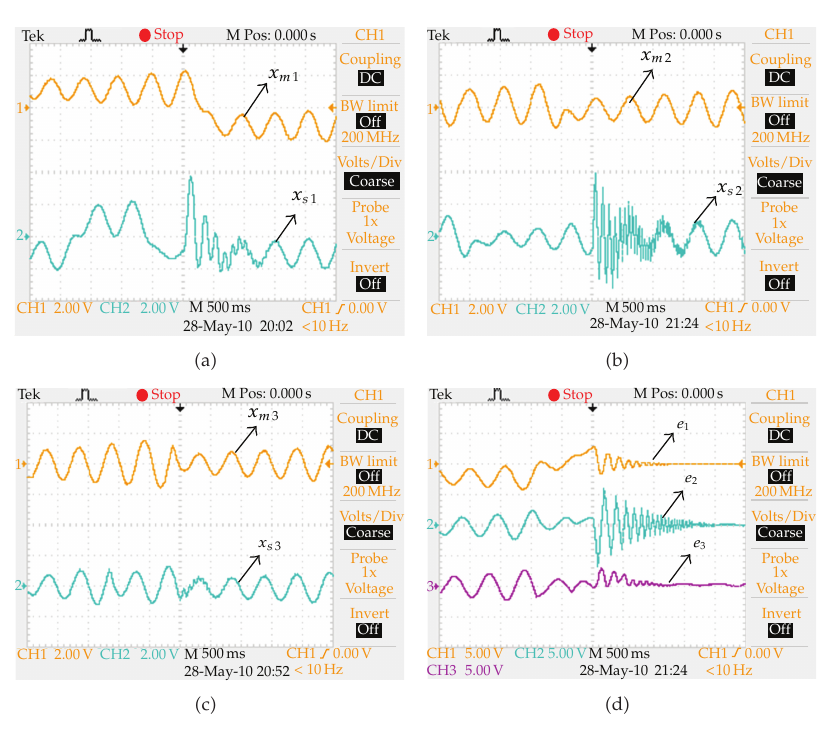
Figure 7: Experimental results of synchronization. (cid:2) a (cid:3) x m 1 versus x s 1 . (cid:2) b (cid:3) x m 2 versus x s 2 . (cid:2) c (cid:3) x m 3 versus x s 3 . (cid:2) d (cid:3) The error states e 1 ,e 2 ,e 3